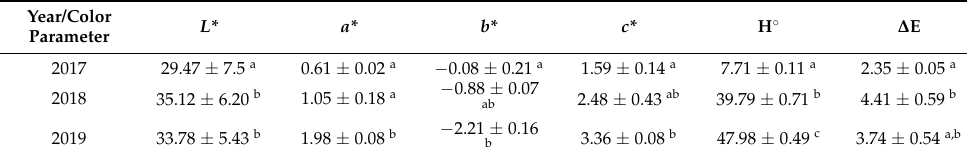
Table 2. CIEL*a*b* color parameters of calafate berries evaluated during three consecutive years: 2017, 2018 and